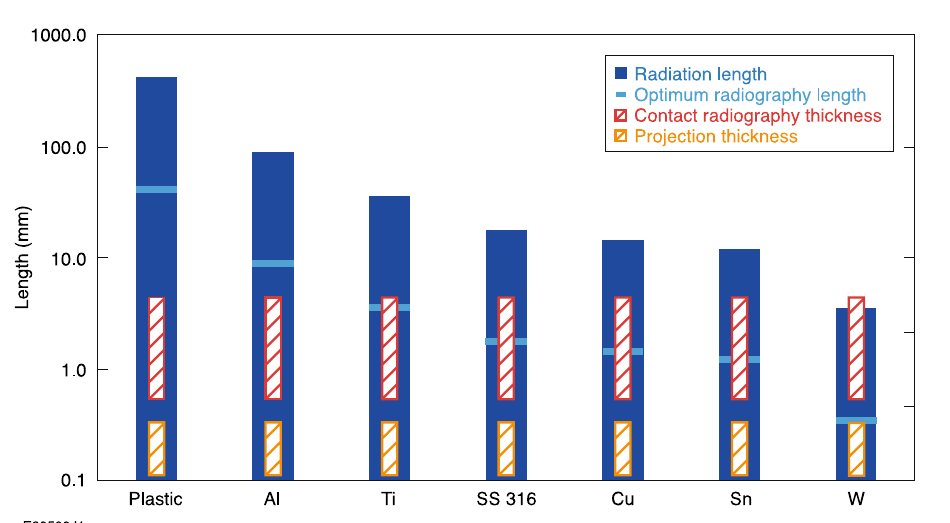
Figure 4. Radiation length 35 and optimal radiography length 13 for all materials radiographed with the OMEGA EP LPA electron